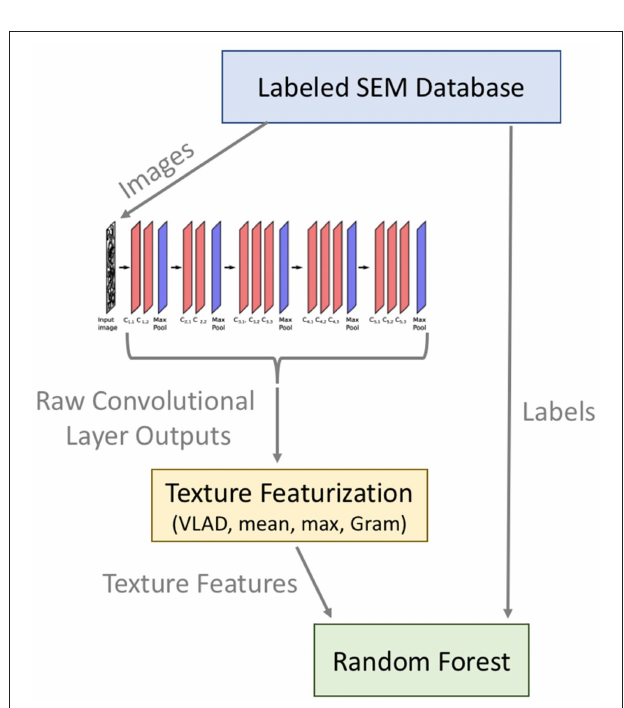
FIGURE 6 | Schematic depiction of the workflow for microstructure feature evaluation. For the image transformation, five stacks of convolutional neural networks were used, each of them consisting of either two or three convolutional layers, succeeded by a max pooling layer. Indices of convolutional layers are referring to their stack position, e.g., first, seconds or third position within the e.g., first, second, third, fourth of fifth stack. The outputs were processed via featurization of the texture and the ultimate classification of these features was achived by using a random forest. Reprinted from Ling et al. (2017), Copyright (2017), with permission from